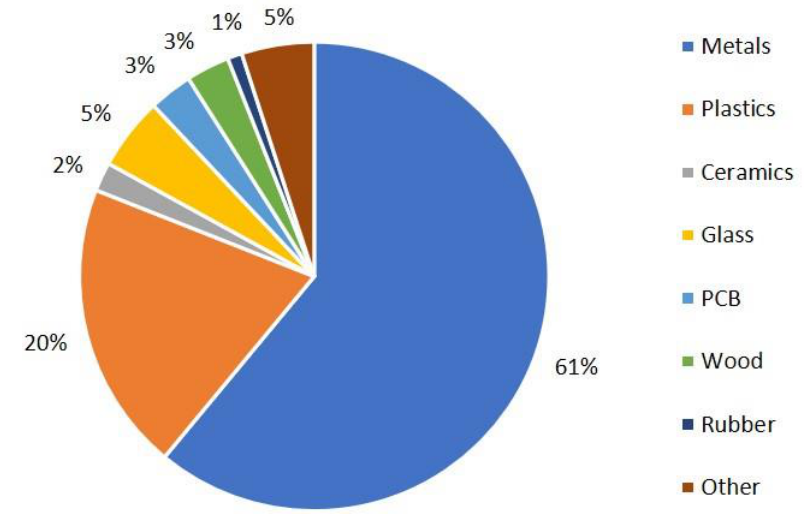
Figure 4. Average percent of various materials found in e-waste (Adapted from Kaya,